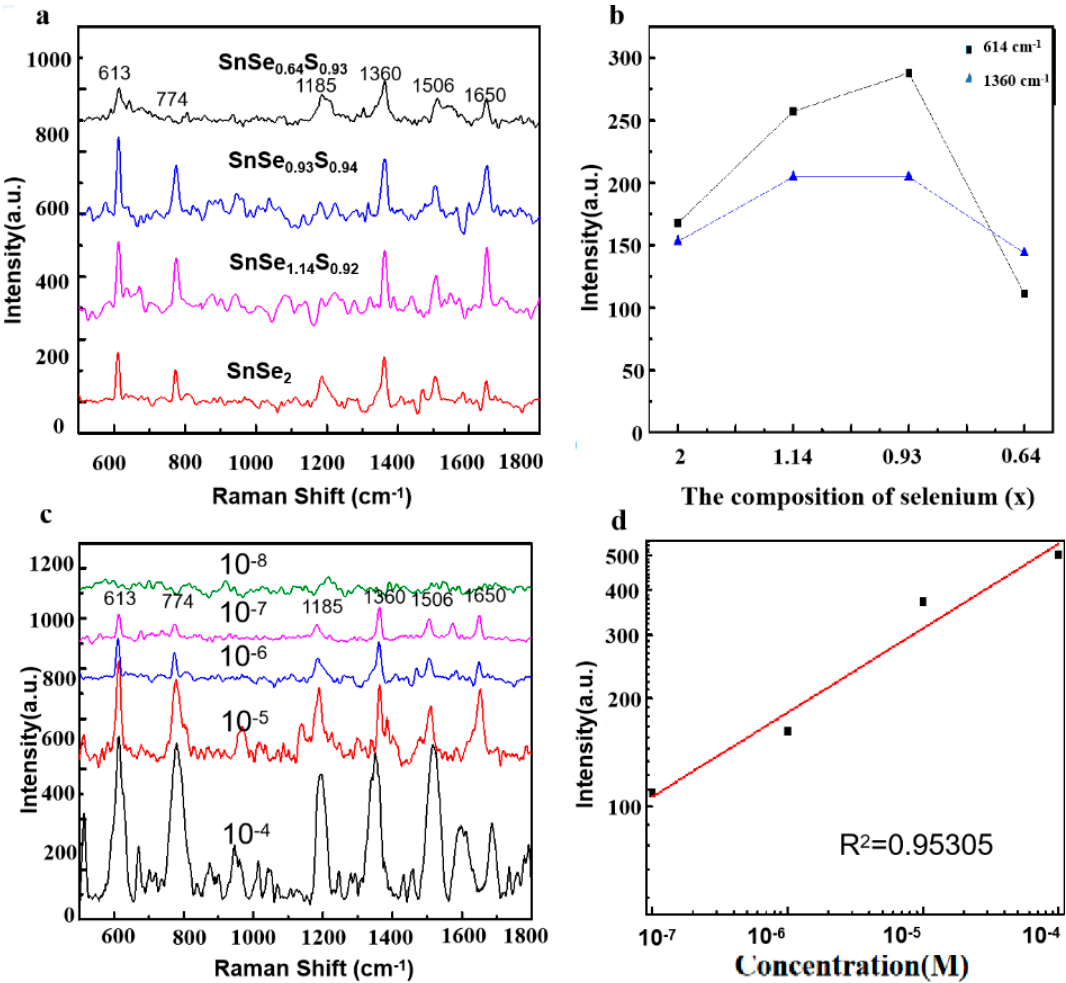
Figure 5. SERS spectra ( a ) and Raman intensities ( b ) of the peaks at 614 and 1360 cm − 1 of 10 − 6 M R6G on different SnSe x S y nanosheets. SERS spectra ( c ) and the peak intensities ( d ) of the peaks at 614 cm − 1 of R6G with concentration ranging from 10 − 8 to 10 − 4 M on SnSe 0.93 S 0.94 nanosheets.